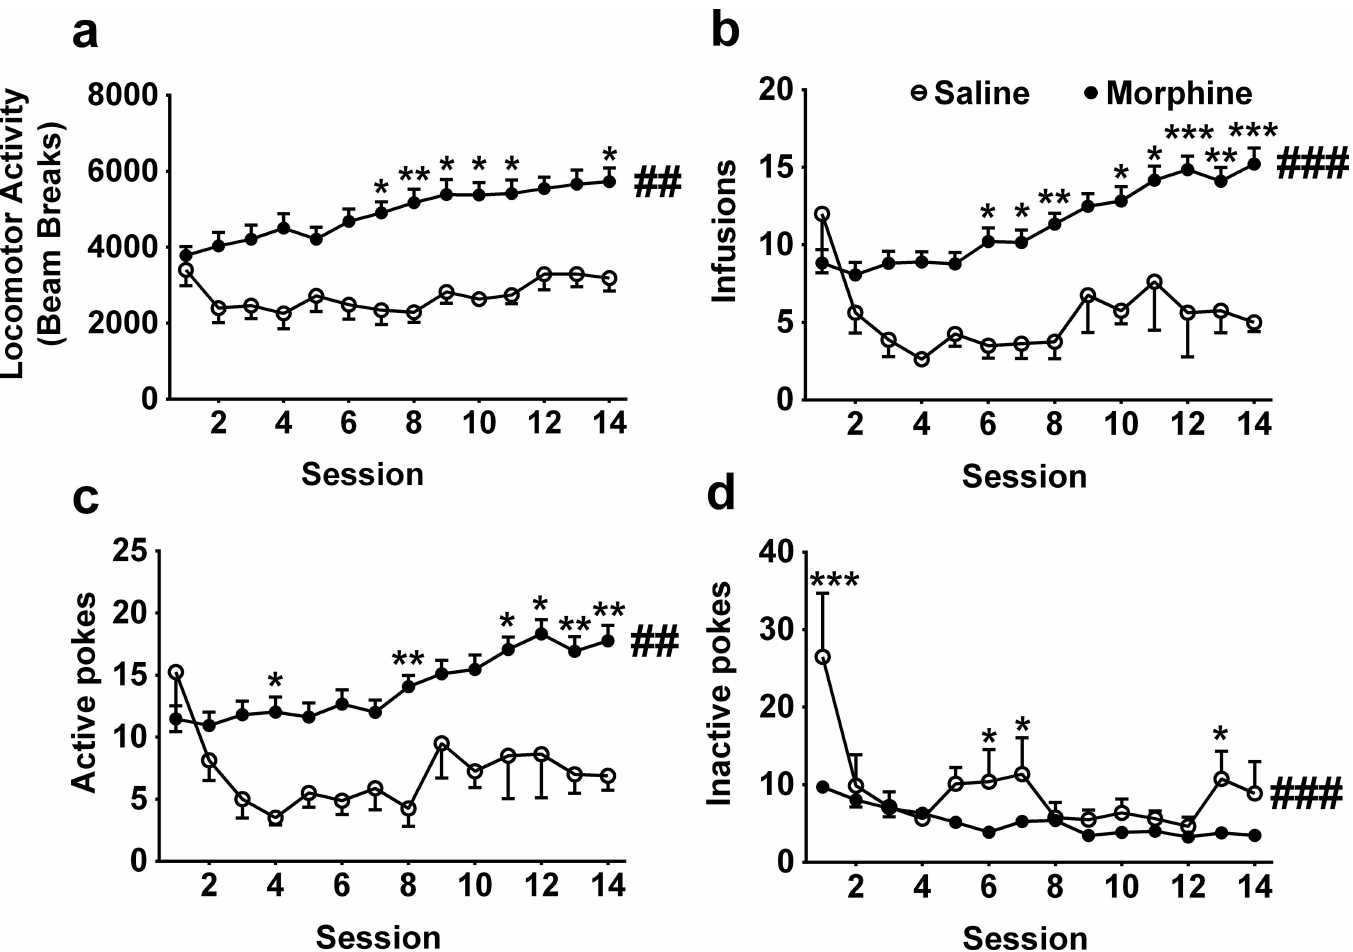
Fig 1. Locomotor activity during morphine self-administration. (a) The locomotoractivity in the morphine SA group was higherthan the saline SA group. (b) The infusionsin the morphineSA group were higherthan the saline SA group. (c) The active pokes in the morphine SA group were higherthan the saline SA group. (d) The inactive pokes in the morphineSA group were lower than the saline SA group. ## p < 0.01, ### p < 0.001, comparedto saline SA. * p < 0.05, ** p < 0.01, *** p < 0.001, post hoc test comparedto saline SA on the same session. SalineSA, n = 8; morphine SA, n = 47.